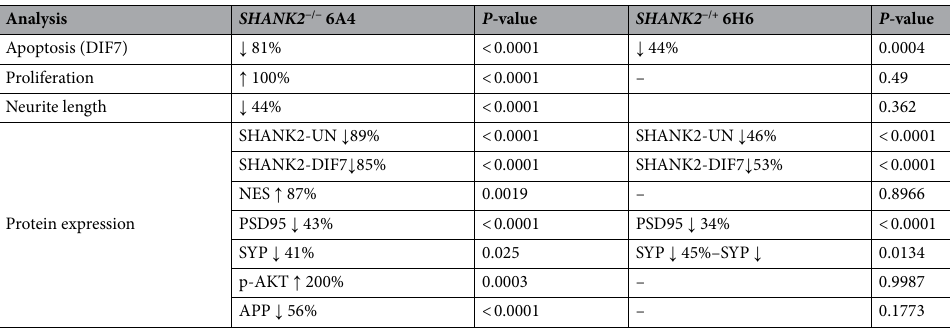
Table 2. Summary of results comparing cell lines with mono-( SHANK2 −/+ ) and bi-allelic ( SHANK2 −/− ) SHANK2 mutations against the controls. The SHANK2 −/− cell line 6A4 showed more extensive alterations in cellular properties; – = no change. The increase is indicated by ↑ and the amount in %, a decrease is indicated by ↓ and the amount in %. Corrected P-values are shown. UN—undifferentiated cells, DIF7—cells after 7 days of neuronal differentiation. NES, PSD95, SYP, p-AKT and APP were analyzed only in cells after 7 days of